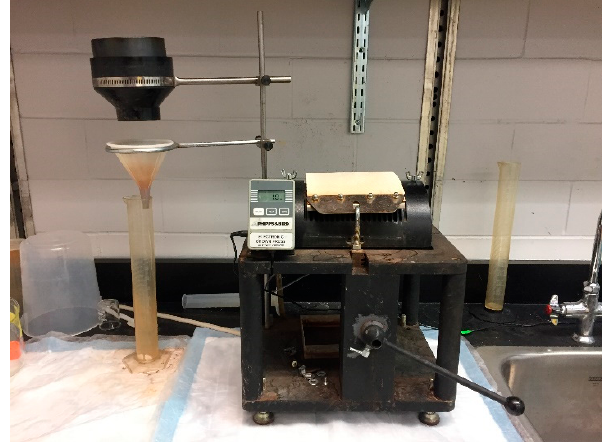
Figure 1. Crown Press—A bench-scale press to assess the dewaterability of biosludge.